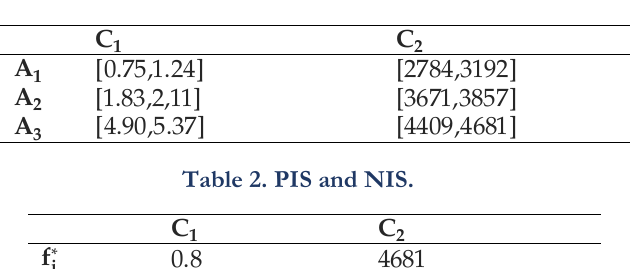
Table 1. Interval decision matrix.